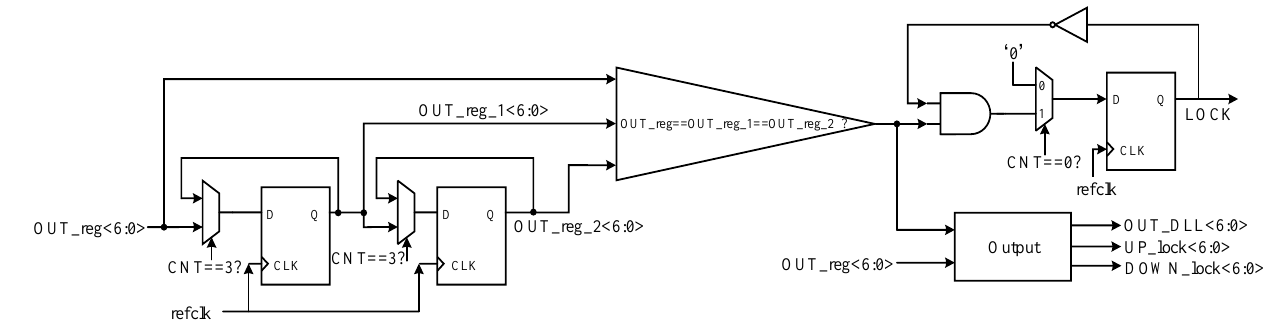
Figure 14. Circuit diagram of the lock module.